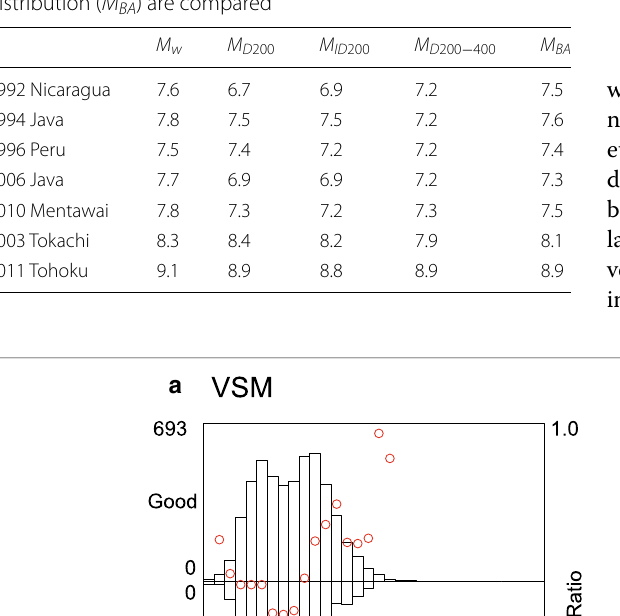
Table 2 Magnitude estimation for finite fault models (U. S. Geological Survey 2020) of tsunami earthquakes and two major earthquakes around Japan. The moment magnitude M w , magnitudes based on highpass-filtered displacement (cutoff period 200 s) ( M D 200 ), highpass-filtered integrated displacement